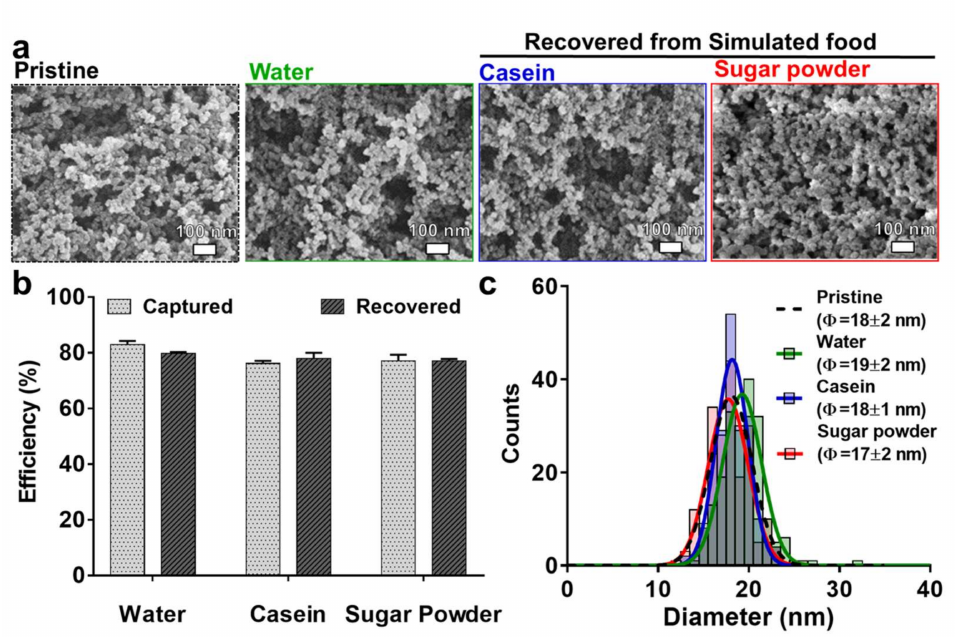
Figure 4. ( a ) SEM images of pristine SiO 2 as a control and recovered SiO 2 from simulated food using SBP-MBP@SMMBs. ( b ) Capture and recovery efficiency of SBP-MBP@SMMBs for the SiO 2 present in various simulated food. ( c ) The size distribution of pristine SiO 2 (black) and recovered SiO 2 from simulated food such as water (green), casein (blue), and sugar powder (red). The SiO 2 content in all simulated foods was 100